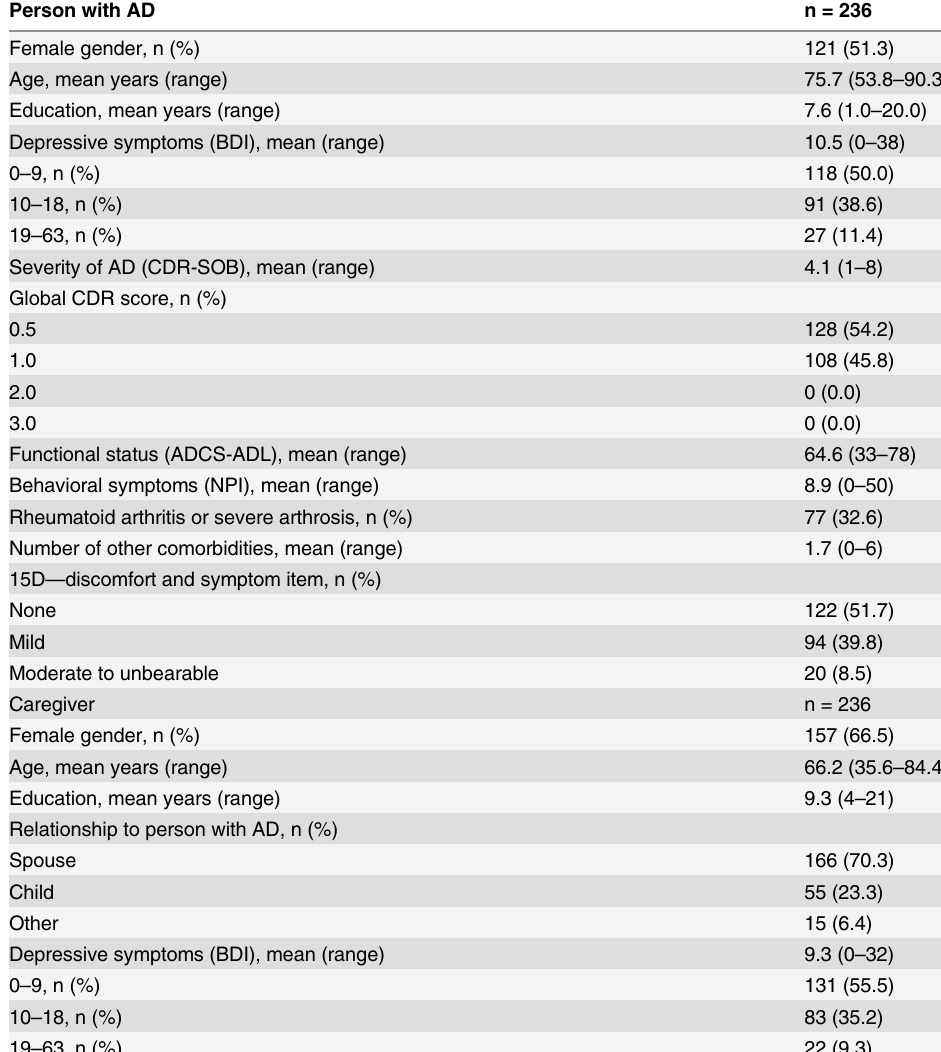
Table 1. Characteristics of persons with AD and their caregivers at